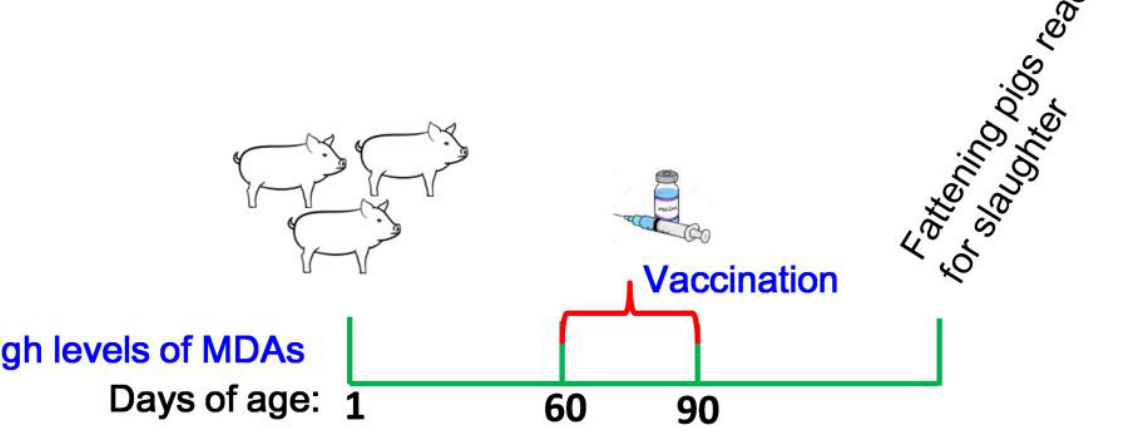
Figure 7. Recommended SVA vaccination schedule for piglets with high levels of MDAs. We recommended that the piglets with high levels of MDAs receive the vaccination of SVA vaccines on days 60 to 90 after farrowing.